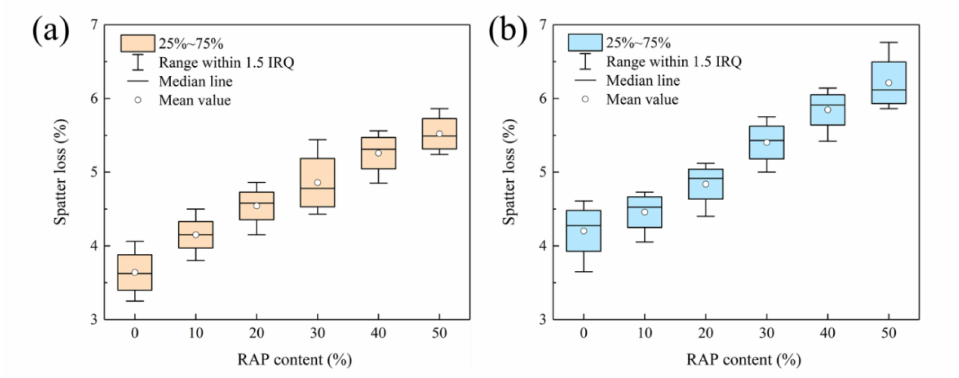
Figure 6. Spatter loss results of RAM: ( a ) steel slag; ( b )